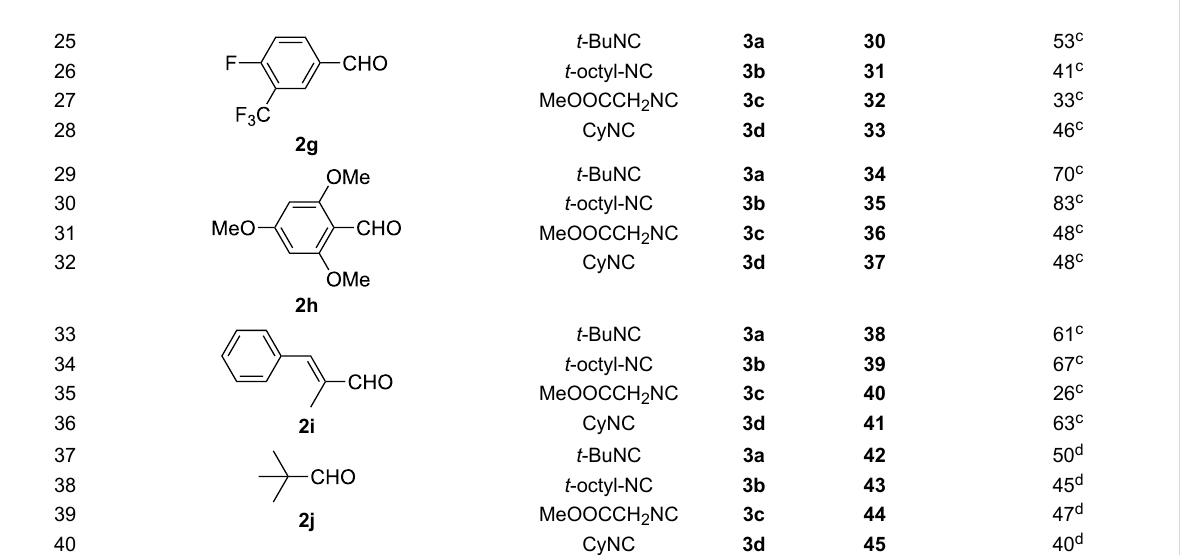
Table 2: Sequential one-pot GBB library generation a . (continued)